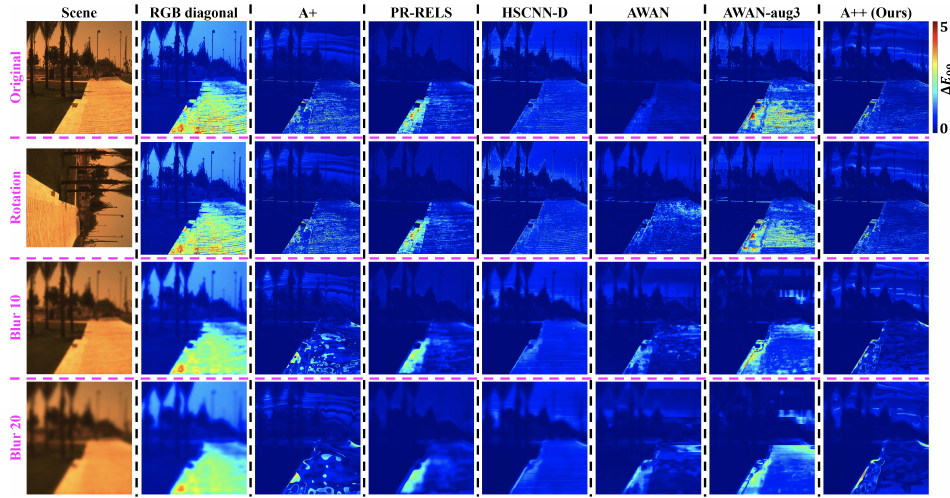
Figure 9. CIE Illuminant A scene relighting error heat maps in ∆ E 00 . The ground-truth relighted scene is shown in sRGB in the leftmost column. From the top to the bottom row, the tested imaging condition is in turn the original, rotation, and two Gaussian blur conditions.